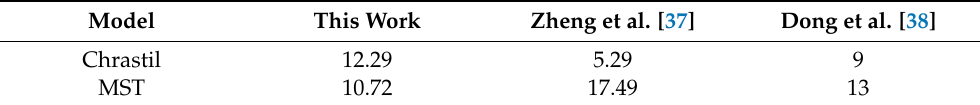
Table 4. AARD values fitted by the same model in this work and previous